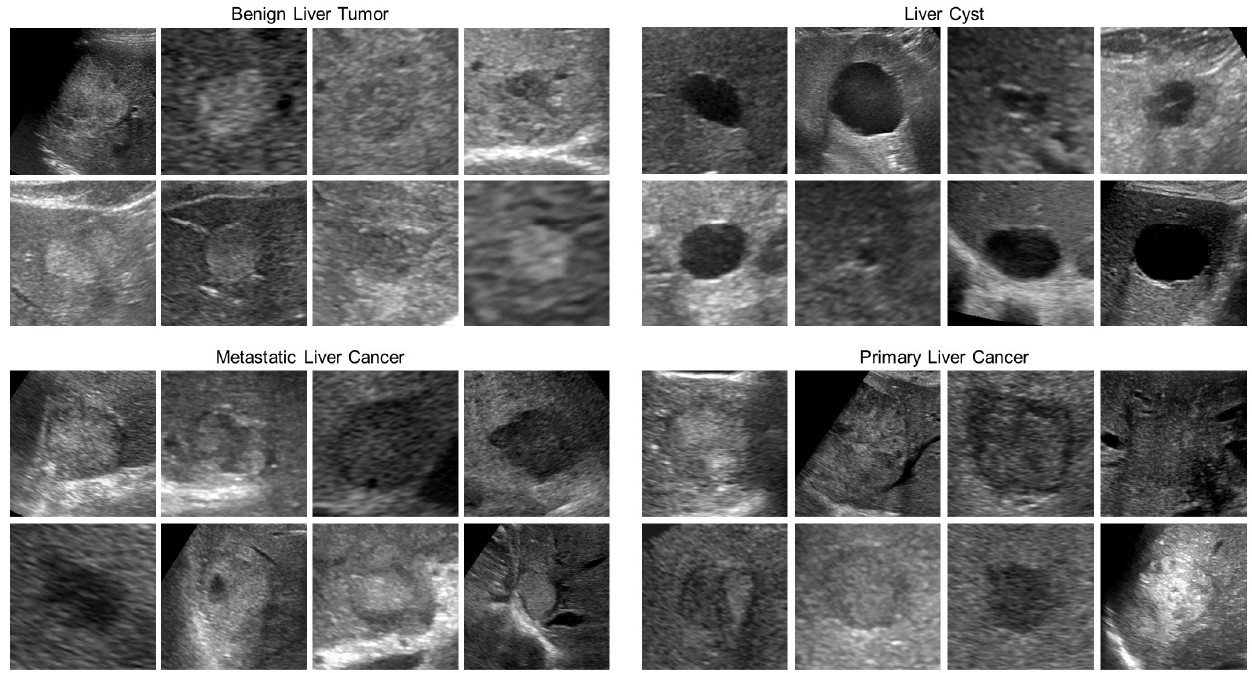
Figure 1. Example of test images. Each B-mode ultrasound image is a grayscale image of 256 × 256 pixels. 256 × 256